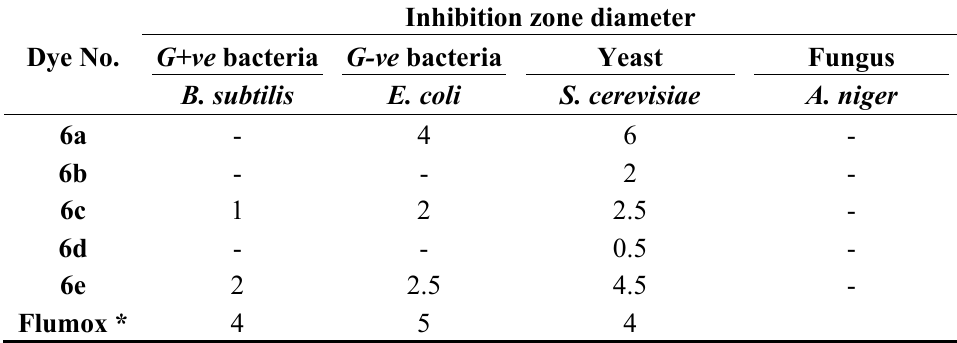
Table 6. Diameter of the zones of inhibition of the tested disperse dyes against Gram positive, Gram negative bacteria, yeast and